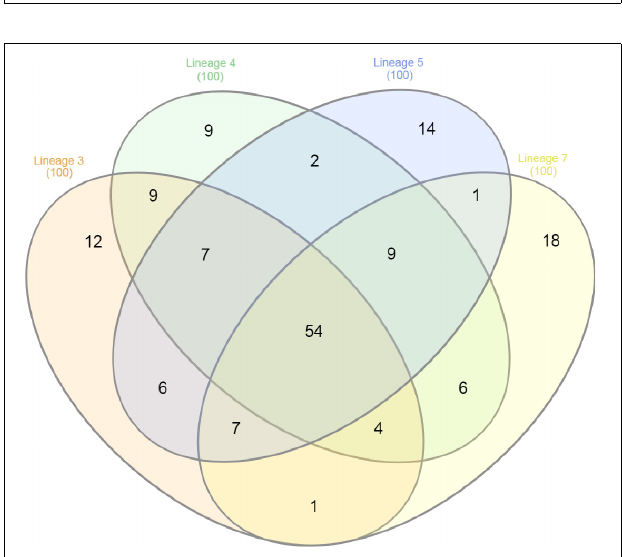
FIGURE 2 | Venn diagram showing protein overlap among the various MTBC lineages of 3, 4, 5, and 7.